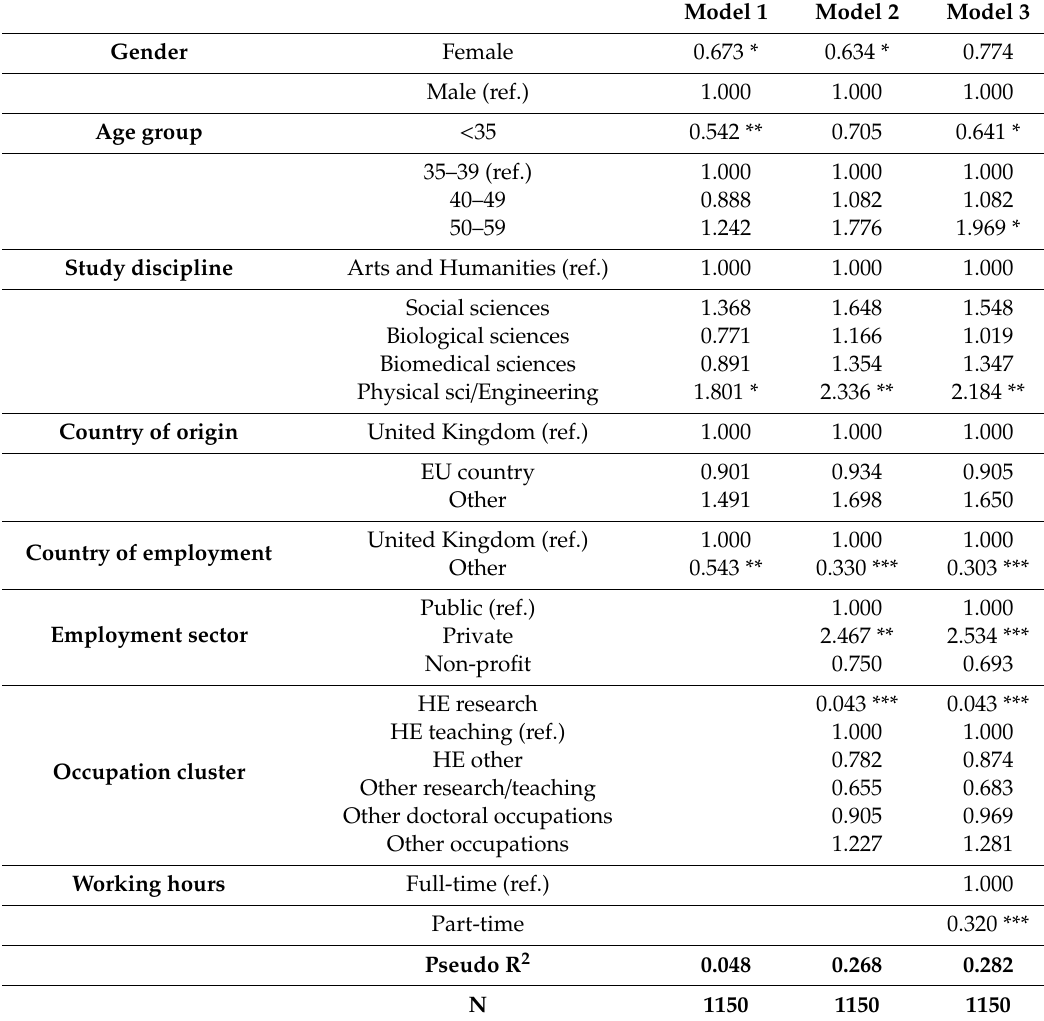
Table 2. Logistic regression analysis model for permanent employment (odds